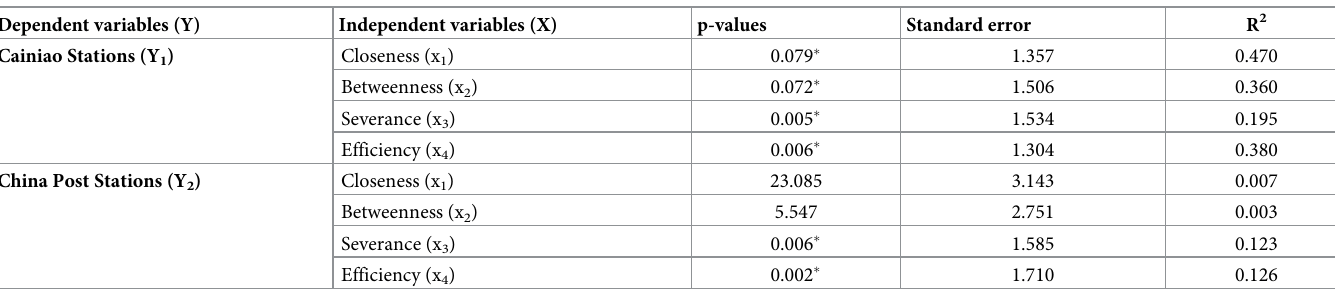
Table 3. Regression results between KDEs of centralities and